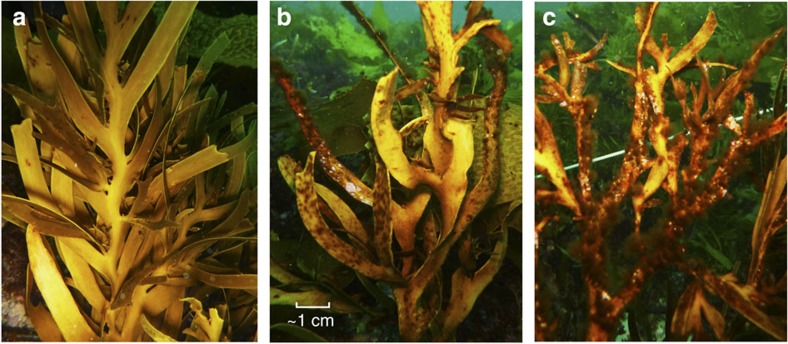
Impact of thermal-stress anomalies on Scytothalia transplants experiencing low and high thermal-stress anomalies.Thallus condition was initially healthy under low stress anomalies (that is, a). Under high stress anomalies thallus deterioration began with brown spotting and other putative disease symptoms (that is, b) before developing into high epibiont cover (c). Note that receptacles remaining in the high-stress anomaly photos are heavily fouled and non-reproductive (c).